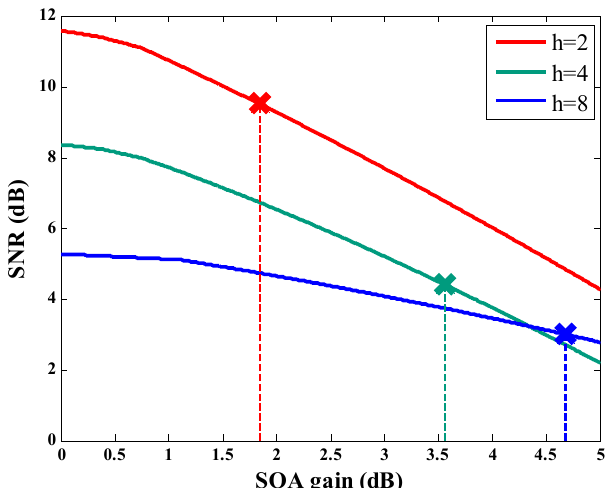
Figure 14. SNR reduction in the region surrounded by the SOA-placed links. X indicates the appropriate SOA gain for the worst-case SNR.